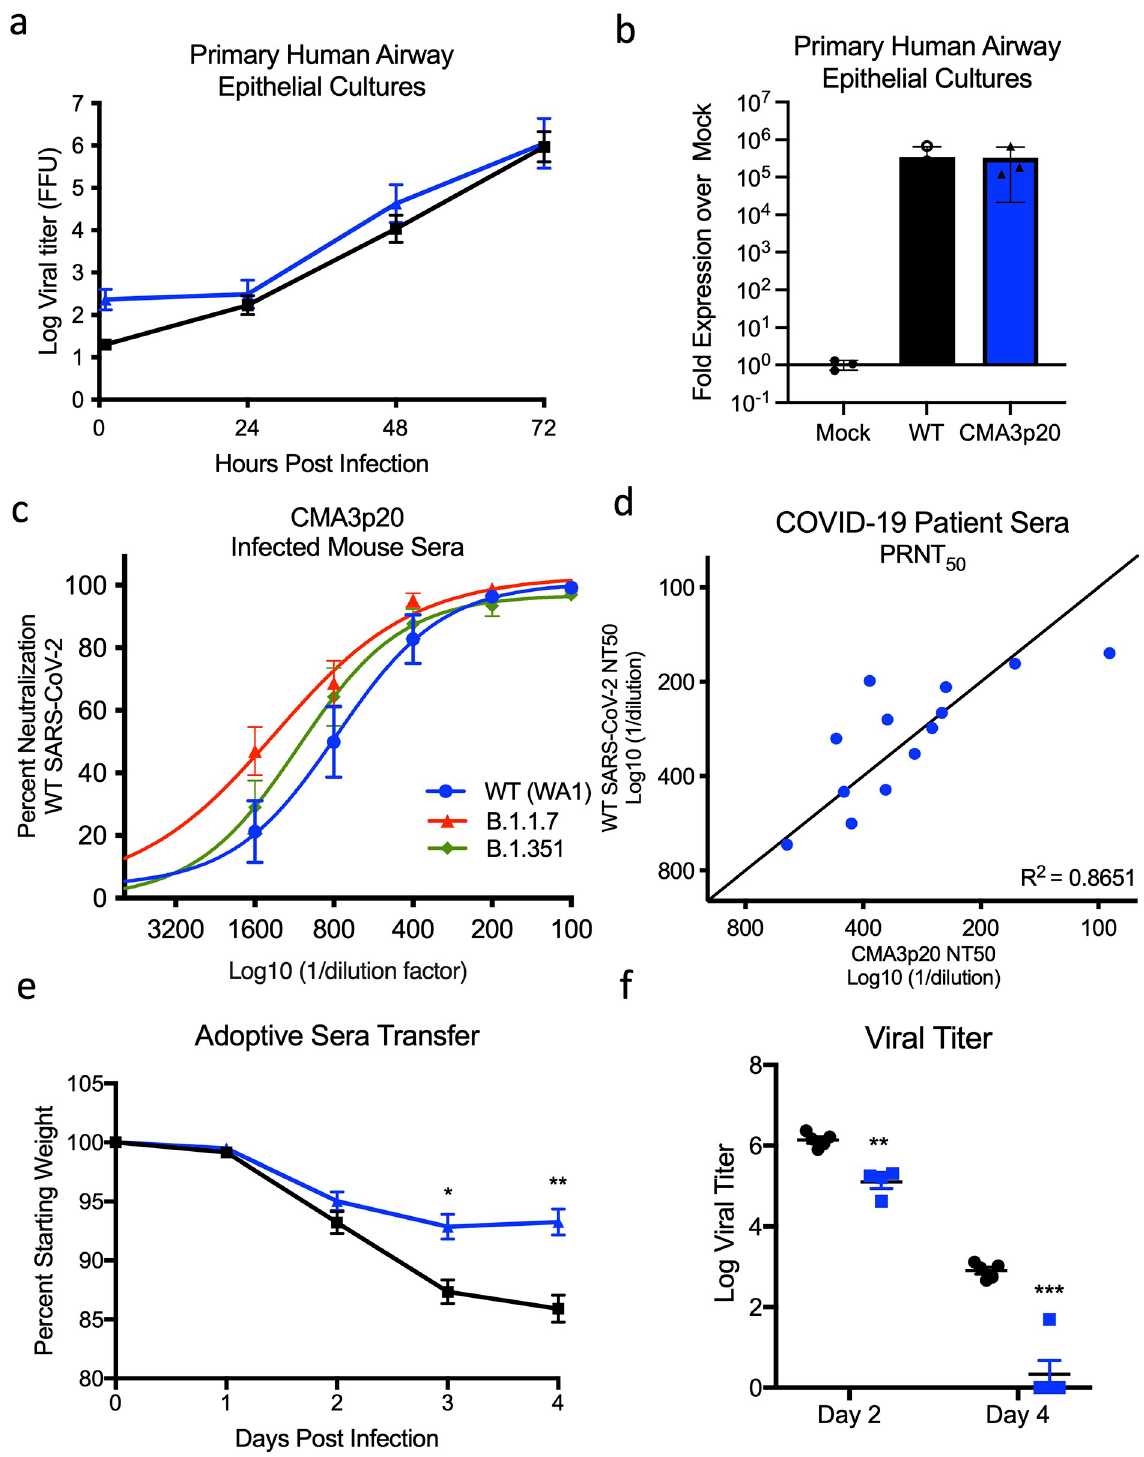
Fig 3. CMA3p20 strain maintains human replication capacity and antigenicity. (a and b) Primary human airway cultures were infected with SARS-CoV-2 WT (black square) or CMA3p20 (blue circles) at an MOI of 0.01 and evaluated for (a) viral titer and (b) viral RNA ( n = 3). (c) Sera collected from female BALB/c mice 28 days postinfection with 10 6 PFU of SARS-CoV-2 CMA3p20 were evaluated for capacity to neutralize WT SARS-CoV-2 (WA1), B.1.1.7, and B.1.351 via PRNT 50 assay ( n = 12). Log10 value of dilution used to plot points on the x-axis. (d) PRNT 50 values from COVID-19 patient sera plotted against WT virus (y-axis) versus CMA3p20 virus (x-axis). (e and f)